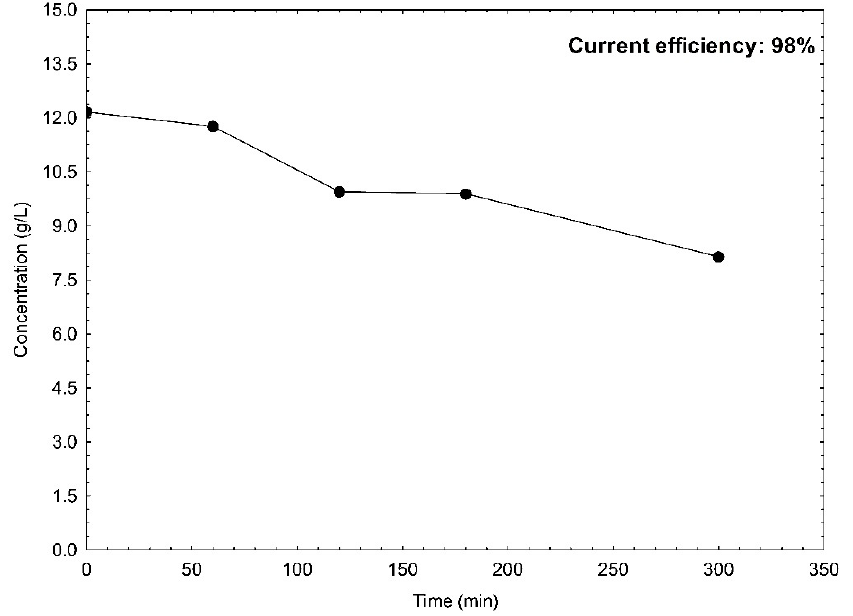
Figure 4. Variation of copper concentration as a function of electrowinning time at 250 A/m 2 , pH = 4 and room temperature for the CuSO 4 synthetic solution.